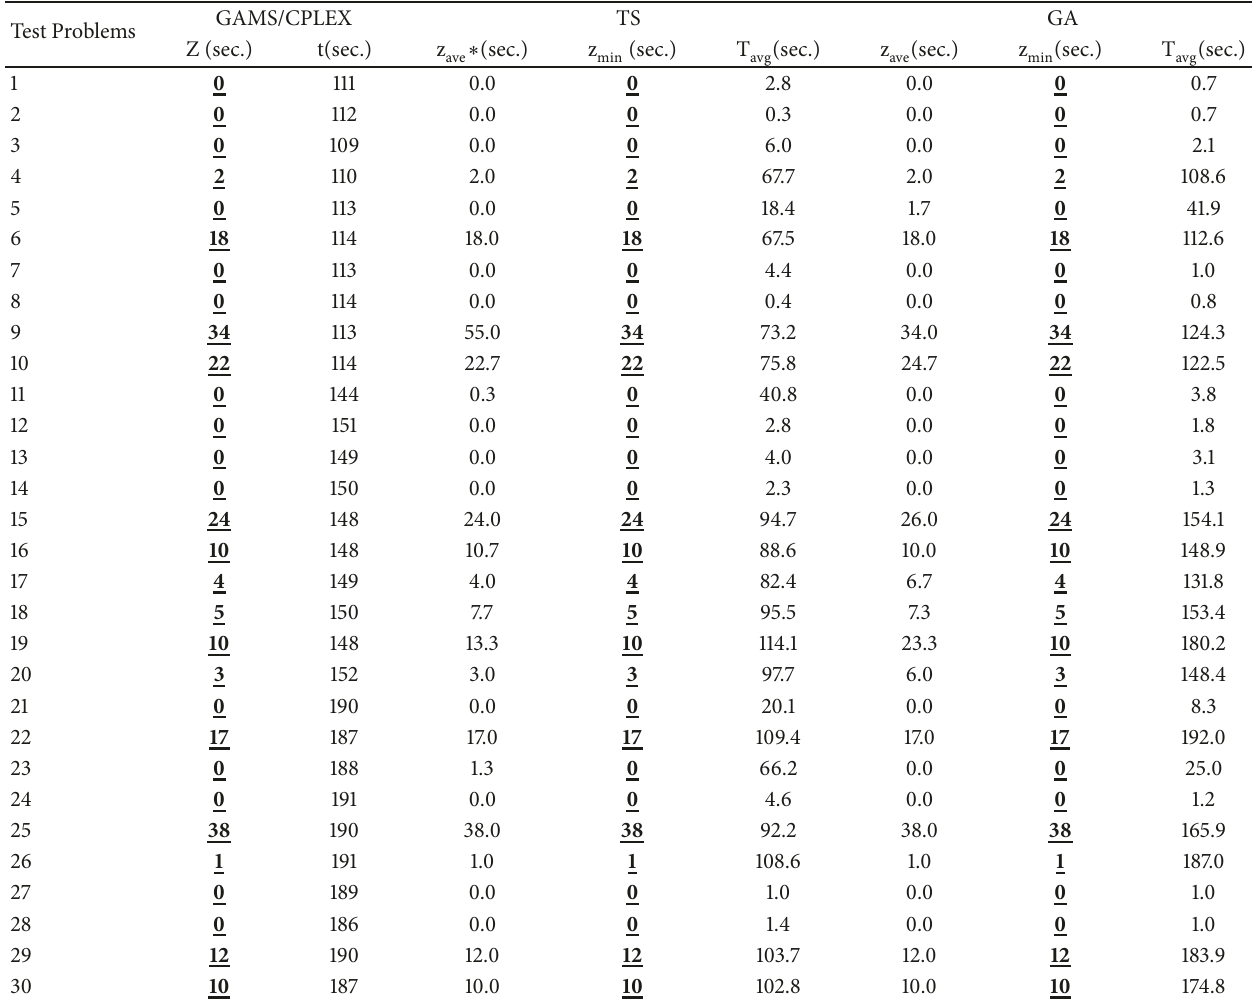
Table 7: Test problem results using GAMS/CPLEX, GA, and TS.